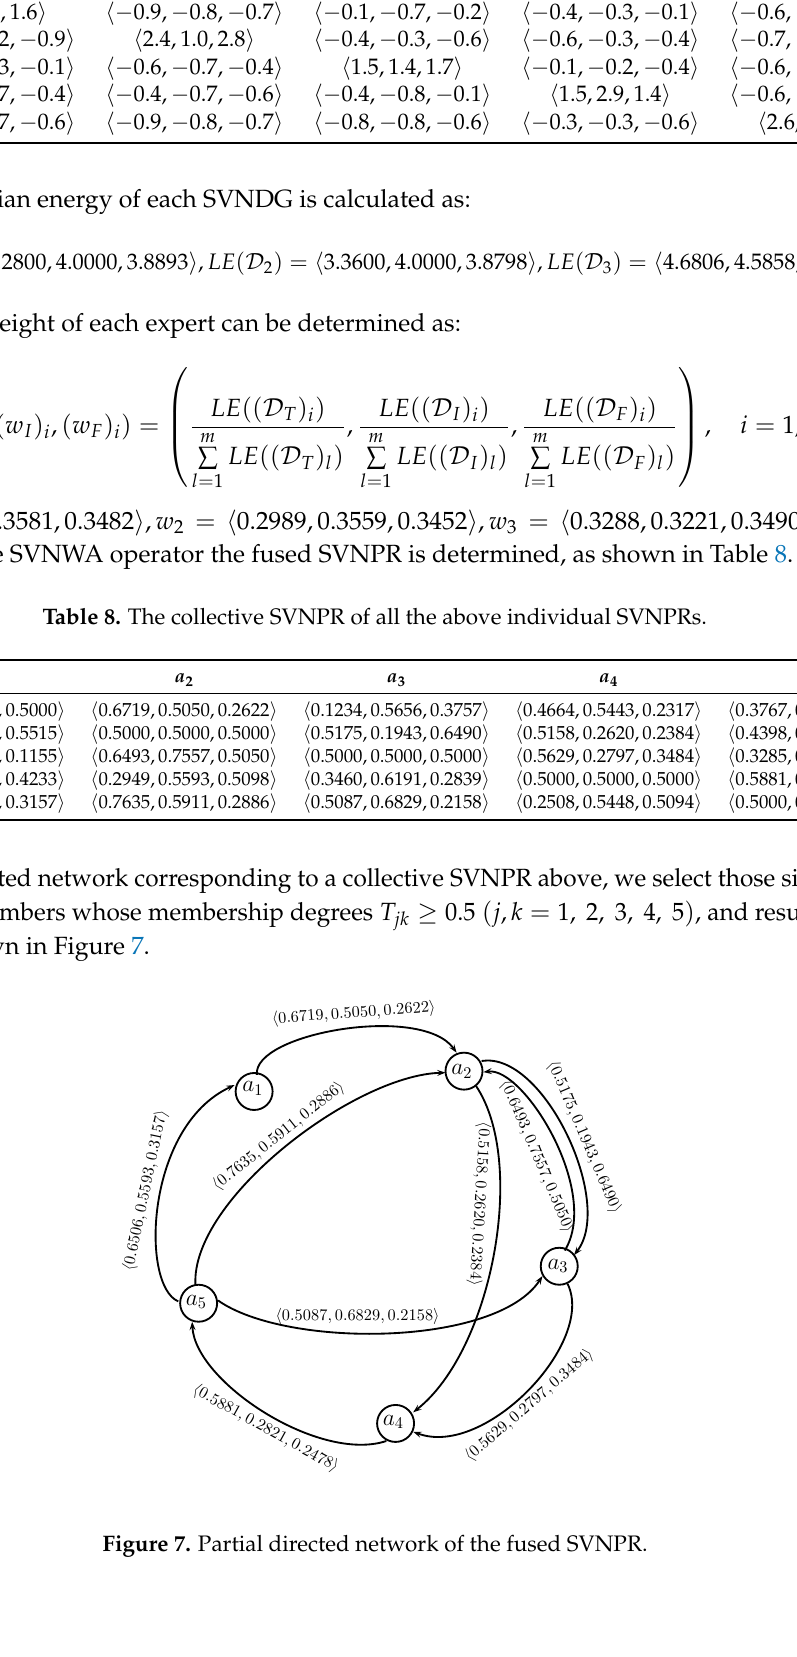
Table 7. Elements of the Laplacian matrix of the SVNDG